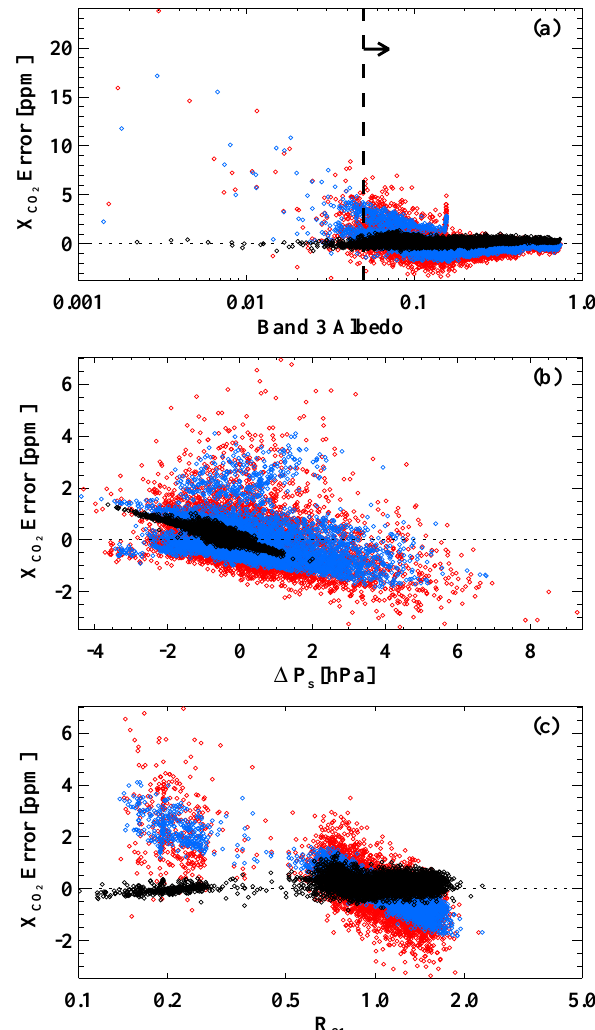
Fig. 7. X CO error versus different quantities for retrievals per- 2 formed on clear-sky simulations. Black points use noise-free sim- ulations and a clear-sky version of the ACOS retrieval, with cloud and aerosol values fixed at zero (test 1). Blue points are for the operational retrieval on simulated spectra free of instrument noise (test 2). Red points are the same but with GOSAT-like noise added (test 3). 1P s is the retrieved minus true surface pressure, and R 21 is the ratio of the continuum signal level in band 2 relative to band 1. For tests 2 and 3 in panels (b) and (c) , only soundings with retrieved band 3 albedo > 0.05 are